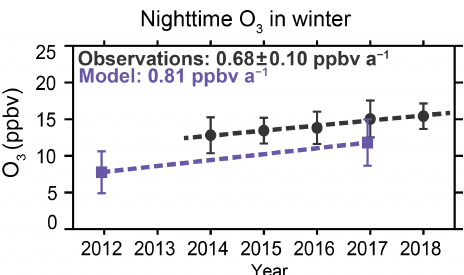
Figure 5. Trend in nighttime surface ozone in China in winter. Val- ues are DJF means over 21:00–05:00 local time for the network of sites in central–eastern China operated since 2013 by the China Ministry of Ecology and Environment (MEE). The sites are grid- ded on the 0 . 5 ◦ × 0 . 625 ◦ GEOS-Chem grid. The symbols are aver- ages for all grid cells containing sites, and the vertical bars are the standard deviation of the spatial distribution. Model values are simi- larly sampled and gridded over the ensemble of MEE sites operating since 2013. Trends are from an ordinary least-squares